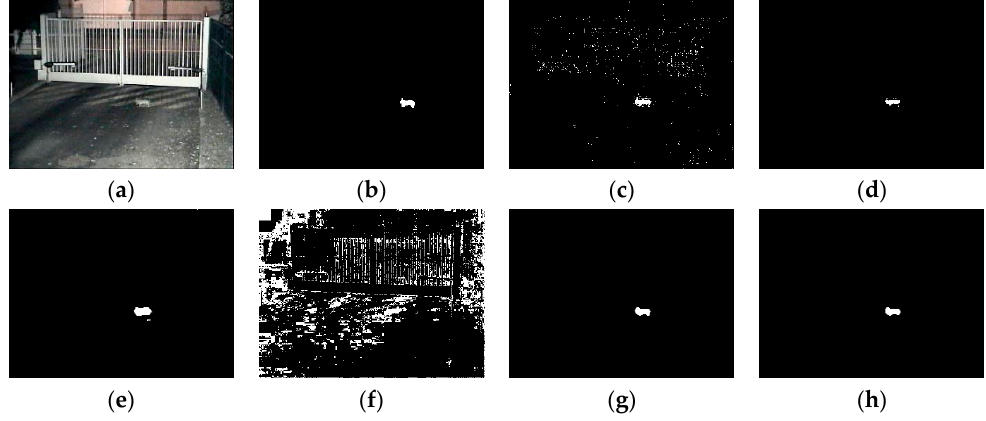
Figure 6. ( a ) Frame 1252 of input images; ( b ) ground truth; ( c ) GMM (Gaussian Mixture Modeling); ( d ) ViBe (Visual Background extractor); ( e ) GMG (an algorithm for finding the Global Minimum with a Guarantee); ( f ) KDE (Kernel Density Estimation); ( g ) LBAdaptiveSOM (Local Background Adaptive Self-Organizing Modeling) ; and ( h ) our method.